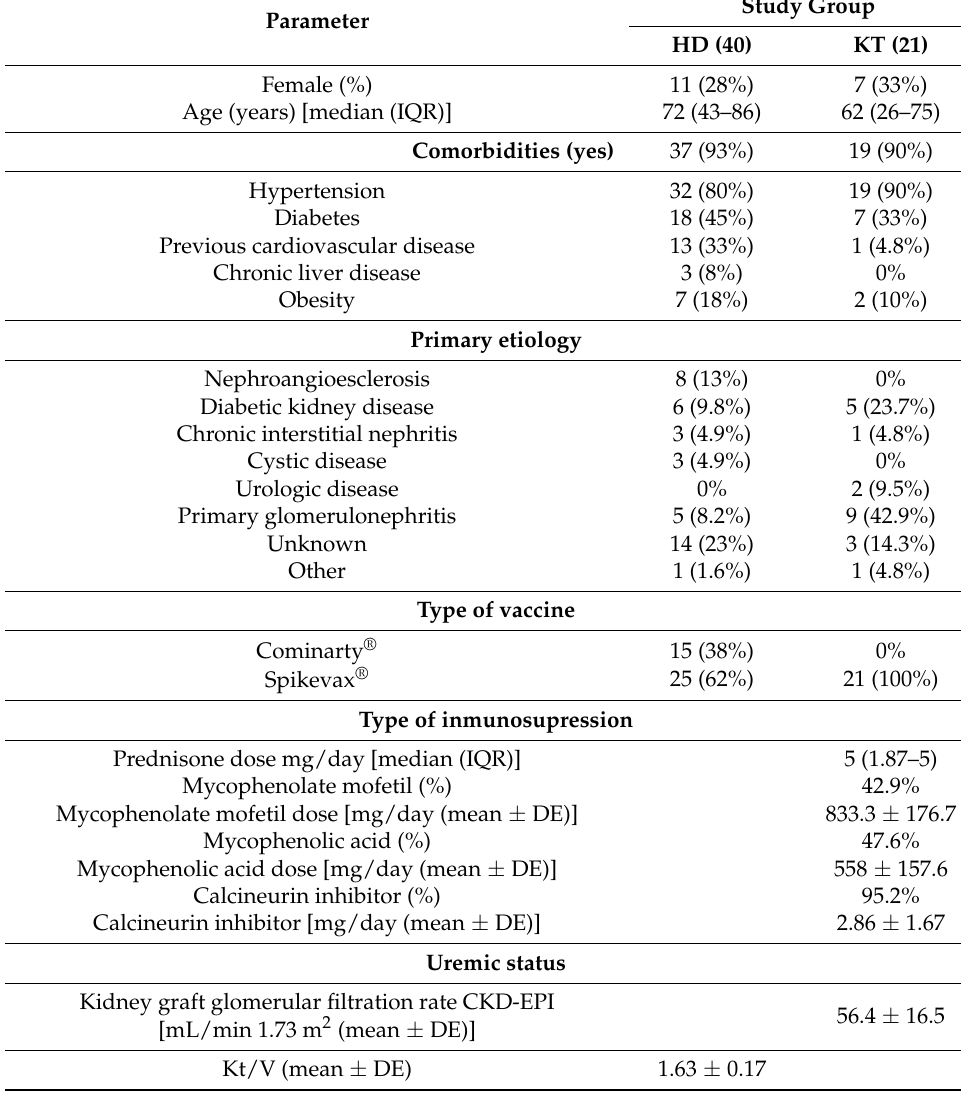
Table 1. Demographic and clinical characteristics of patients in the two